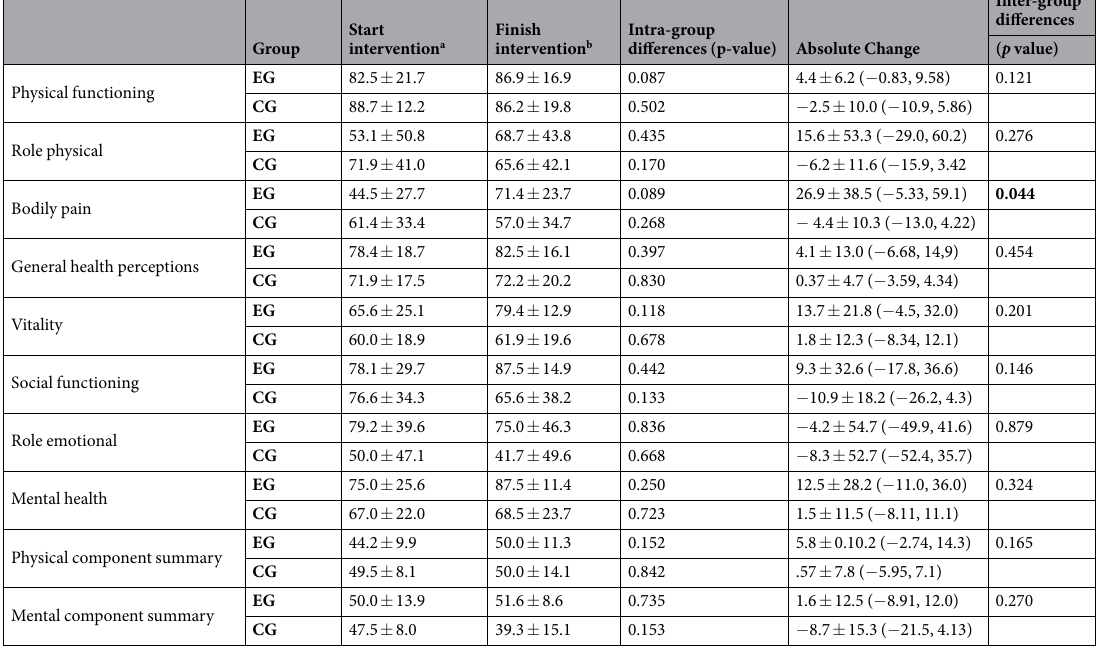
Table 3. Changes in SF-36 scores after exercise program. Data are mean ± SD. 95% confidence intervals in brackets. EG, exercise group; CG, control group. Note: a 37 months after surgery; b 42 months after